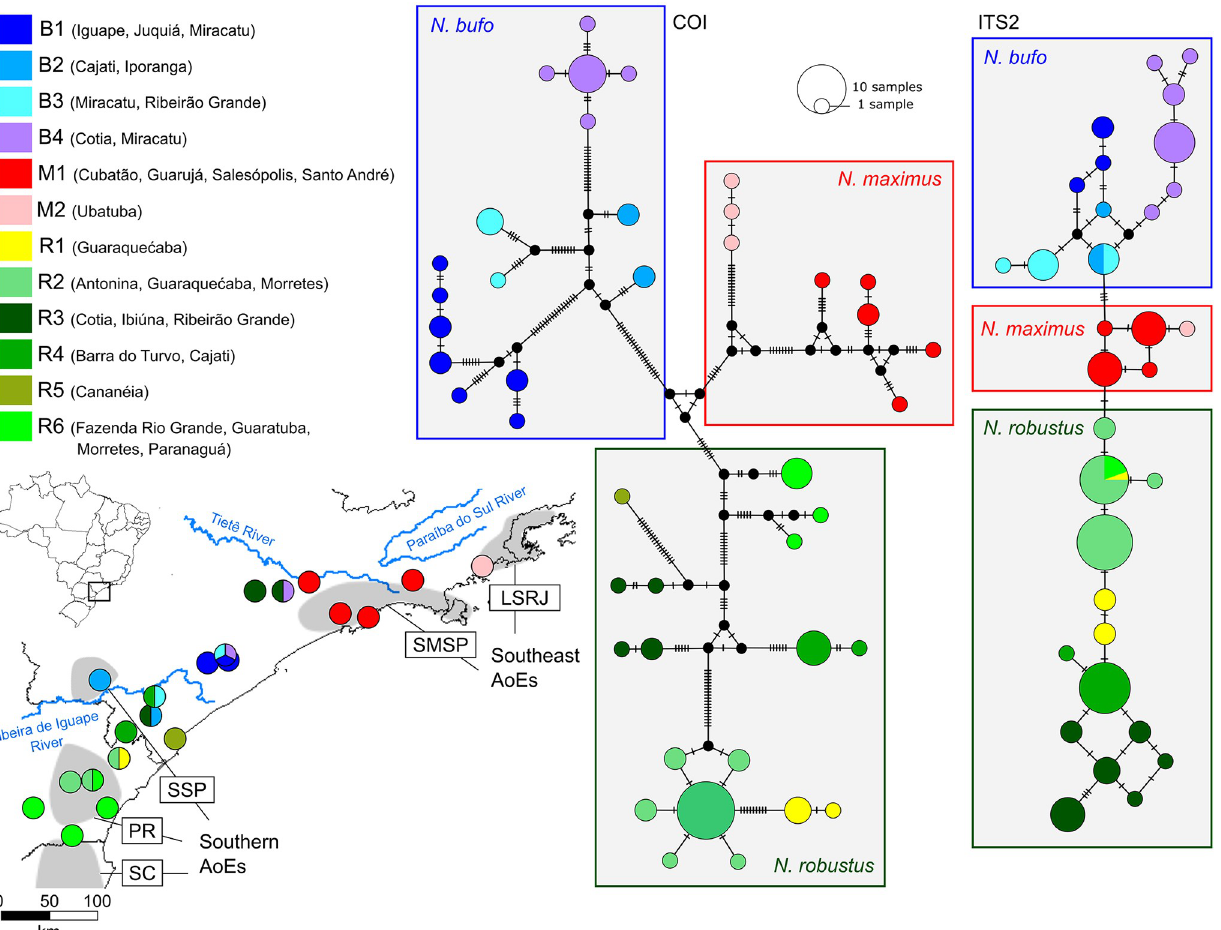
Fig 14. Haplotype networks and structure obtained with BAPS. The colors represent the genetic clusters indicated for COI sequences: N . bufo = B1–B4; N . maximus = M1–M2; N . robustus = R1–R6 (the information was extrapolated for ITS2 data, which exhibited a less marked subdivision). In the map, the main rivers and Areas of Endemism (AoEs) mentioned in the discussion are shown (LSRJ = Southern Rio de Janeiro Coast; SMSP = Serra do Mar of S ã o Paulo; SSP = Southern S ã o Paulo; PR = Parana´; SC = Santa Catarina; adapted from [20]). Map elaborated with free, public shapefiles available on DIVA-GIS software website